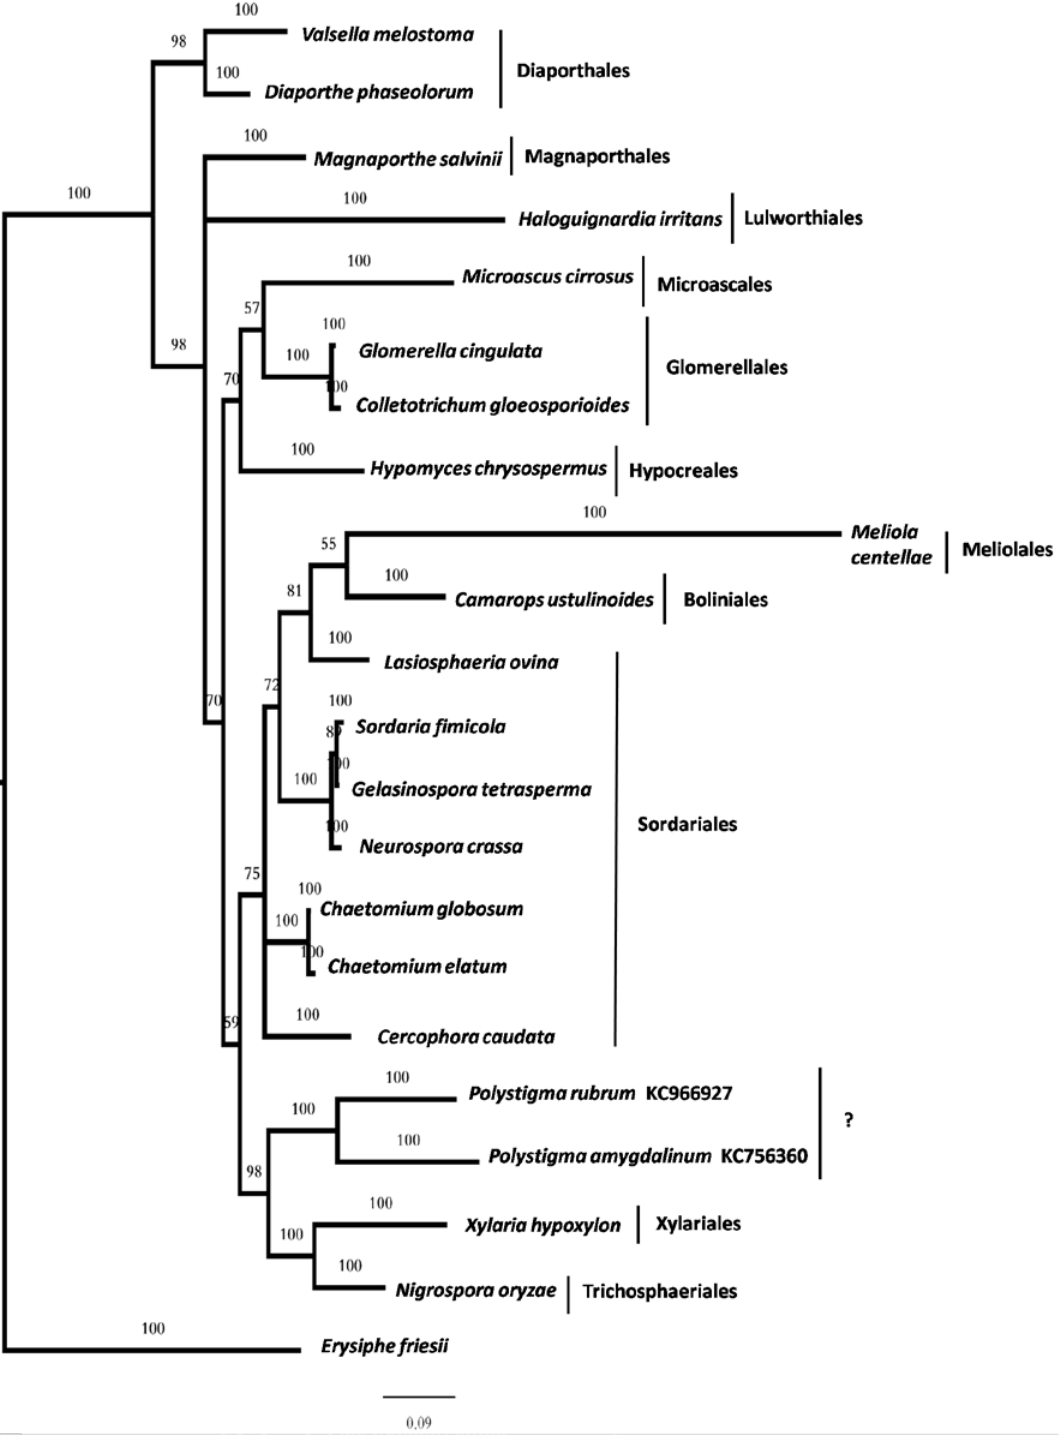
Figure 2. Bayesian phylogenetic tree of species belonging to different orders of Sordariomycetes based on ITS sequences. Bayesian posterior probabilities (probability %) are shown next to the branch points. The scale bar represents the number of changes per